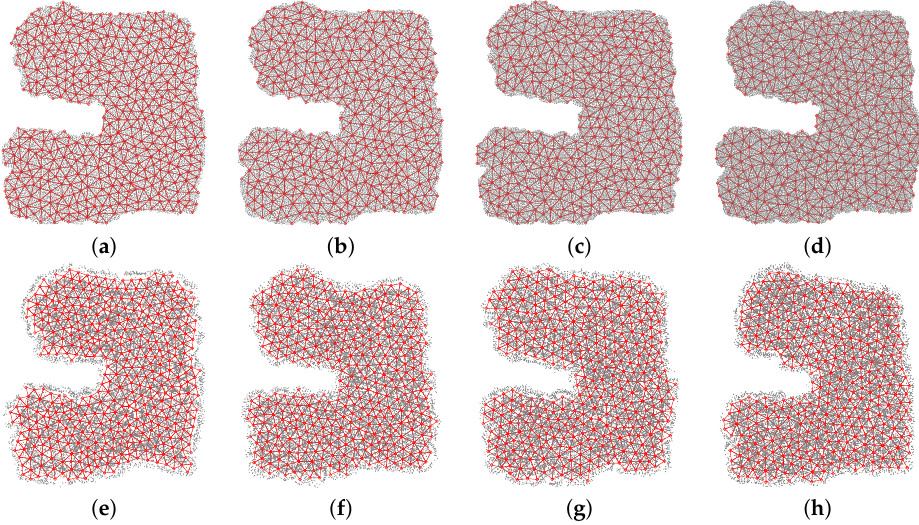
Figure 5. Networks with variant nodal density: ( a – d ) The original network with increased nodal density; ( e – h ) the localization results of our algorithm. All of the networks share the same communication radio range and are under the same transmission model. We compute the difference of each node-pair’s distances in the original and localized networks. Then, we calculate the localization error as the ratio of the average difference of node-pair’s distances and the one-hop communication radio range. Specifically, the average nodal degrees for networks shown in ( a – d ) increase with d = 9.4, d = 12.6, d = 15.2, d = 18.5, respectively. The localization errors of networks shown in ( a – d ) decrease with 0.514,0.322,0.28,0.246, respectively. ( e – h ) show the corresponding